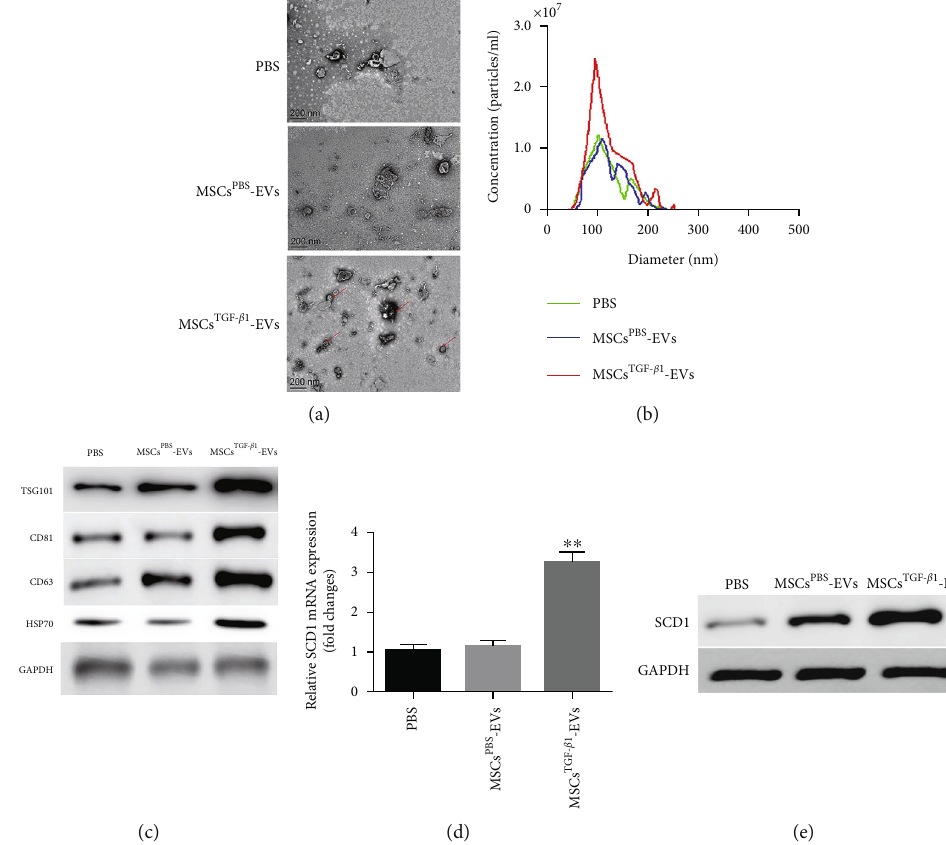
Figure 2: TGF- β 1 promotes SCD1 expression and EV release from MSCs. (a) Morphology of EVs derived from MSCs treated with PBS or TGF- β 1, n = 3 . (b) NTA of EVs derived from the PBS, MSC TGF- β 1 -EV, and MSC PBS -EV groups, n = 3 . (c) Western blot analysis of EV markers, including TSG101, CD81, CD63, and HSP70, n = 3 . (d, e) The expression level of SCD1 in the MSC TGF- β 1 -EV and MSC PBS -EV groups was detected by RT-PCR (d) and western blotting (e), n = 3 . Data are expressed as mean ± SD ; ∗∗ P < 0 : 01 . MSCs: mesenchymal stem cells; EVs: extracellular